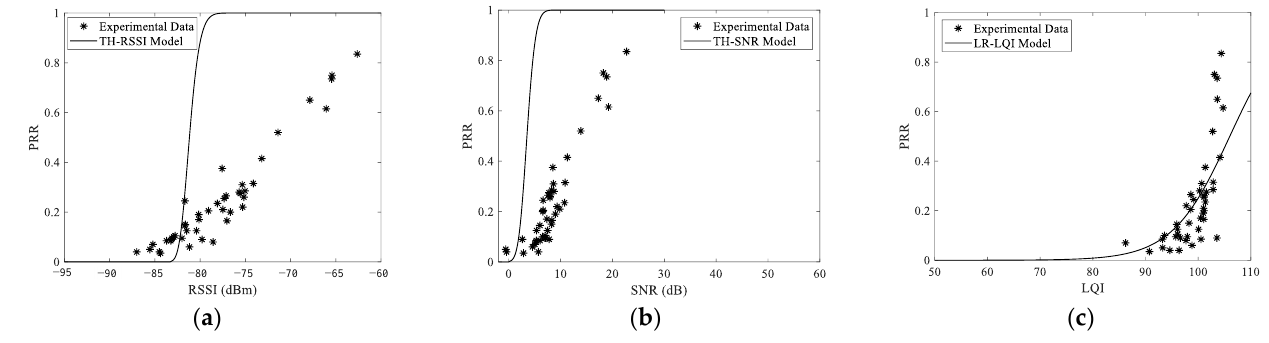
Figure 14. Typical link quality metrics and models with the 2.4 GHz UAV: ( a ) RSSI and its theoretical model with PRR, ( b ) SNR and its theoretical model with PRR, ( c ) LQI and its logistic regression model with PRR.